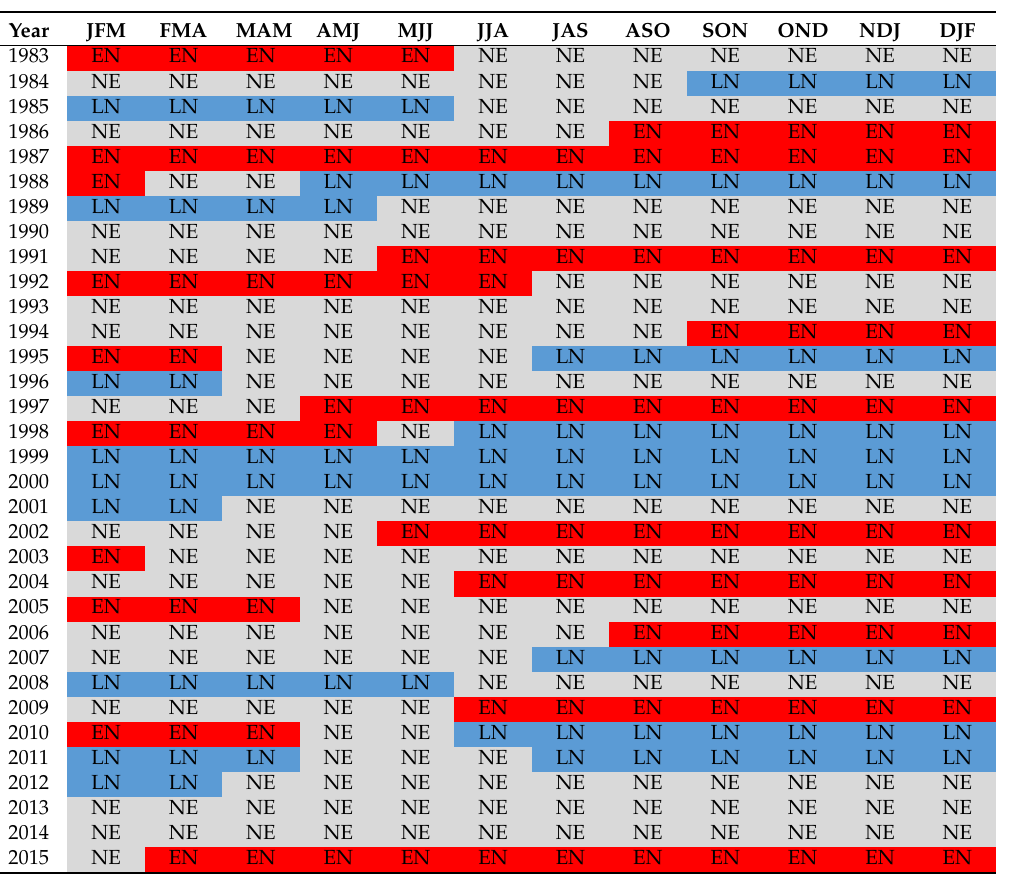
Table A1. Three-month ENSO classification using the Oceanic Niño Index (ONI) where NE ( ) is Neutral, EN ( ) is El Niño and LN ( ) is La Niña [53].